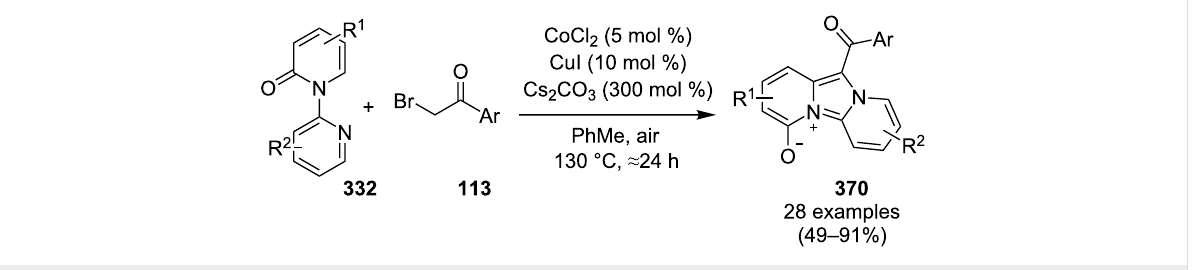
radical pathway that was clear by the mechanistic Scheme